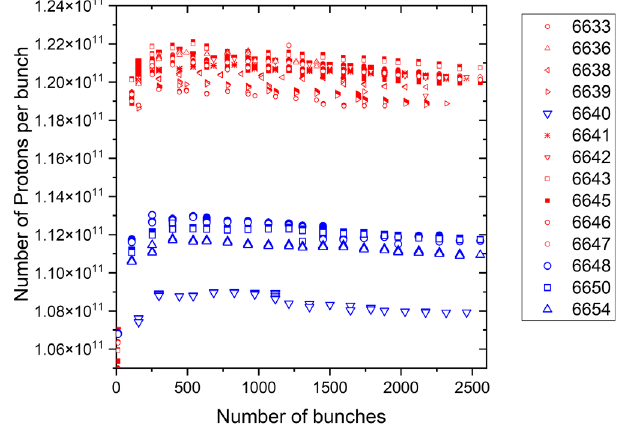
FIG. 5. Evolution of the number of protons per bunch in station 4 (beam 1) as a function of the number of bunches during injection at 450 GeV for several fills (recorded between May 3 and May 7, 2018). Red symbols correspond to fills for which a pressure increase during injection is observed, blue symbols are related to fills for which no pressure increase occurred.